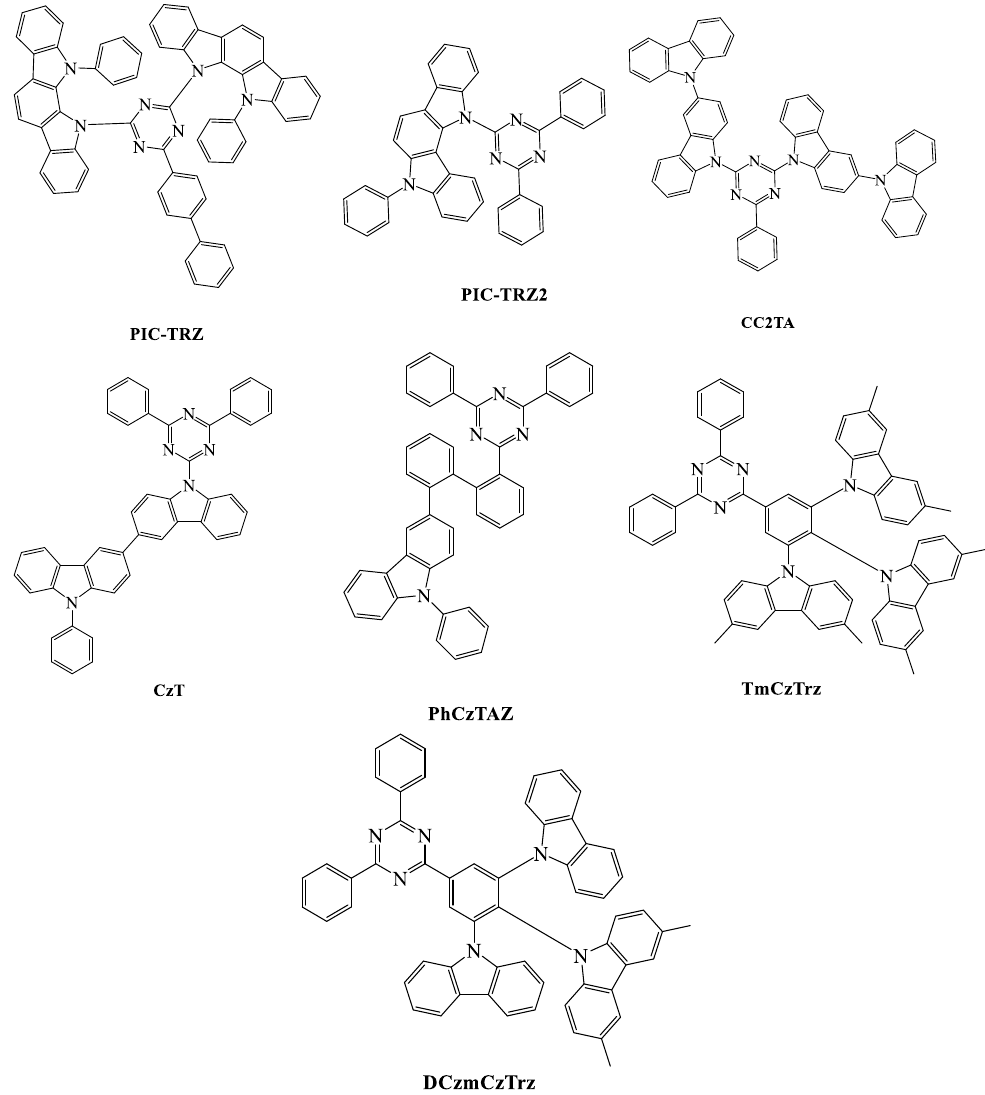
Figure 1. Molecular structures of triazine acceptors with carbazole donor moieties.